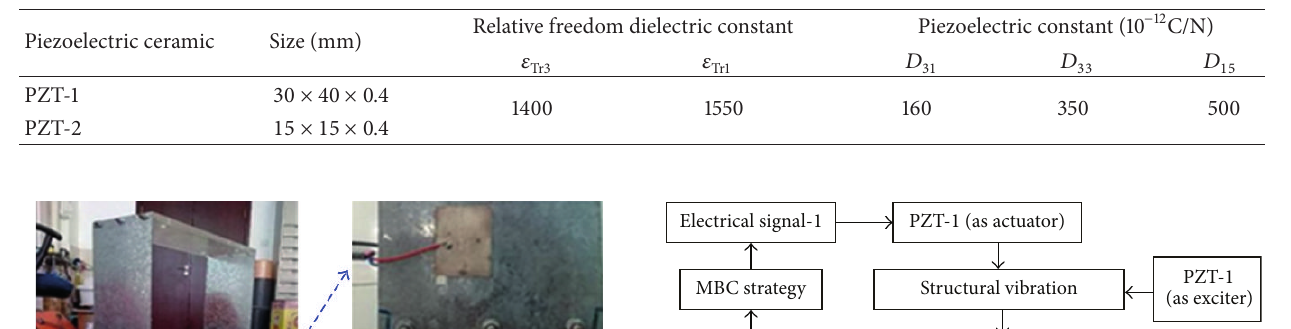
Table 2: Parameters of the piezoelectric.